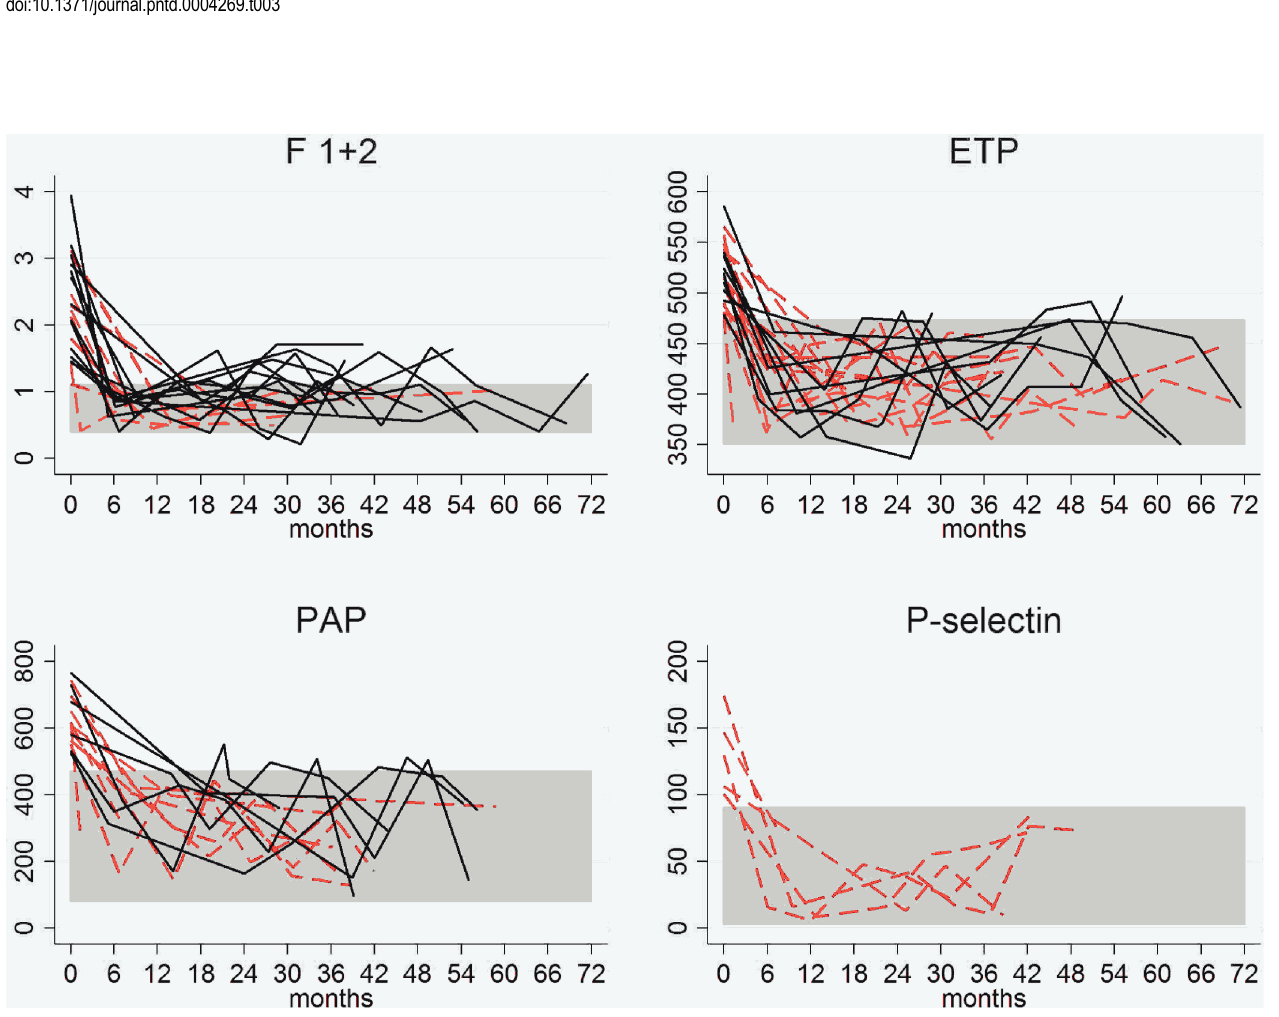
Fig 1. Hemostasis factor levels (baseline and follow-up) in patients with altered levels before treatment who achieved levels within normal ranges during follow-up. * The discontinuous red lines indicate patients who maintained normal values throughout follow-up. The continuous black lines indicate patients who experienced a return to abnormal values at some time during the follow-up. Abbreviations: ETP, endogenous thrombin potential; F 1+2, prothrombin fragment 1+2; PAP, plasmin-antiplasmin.